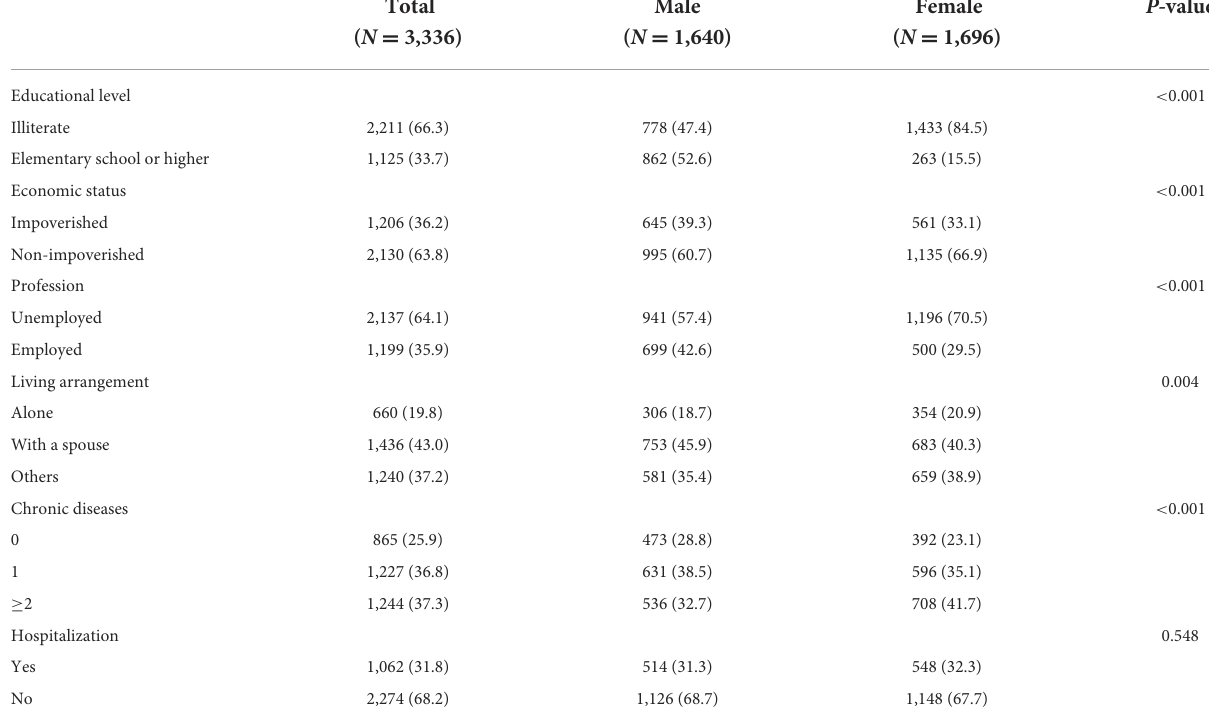
TABLE 1 Sample characteristic by genders, N